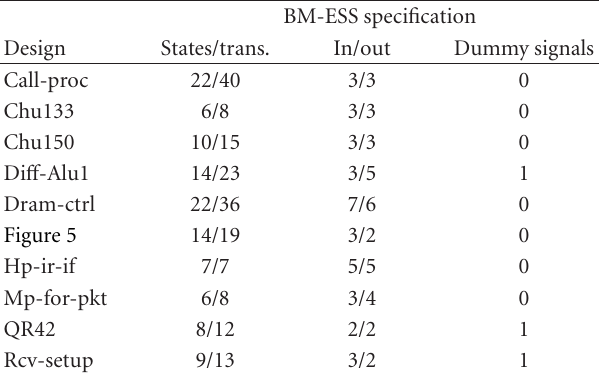
Table 3: BM-ESS specifications lead to the following data.